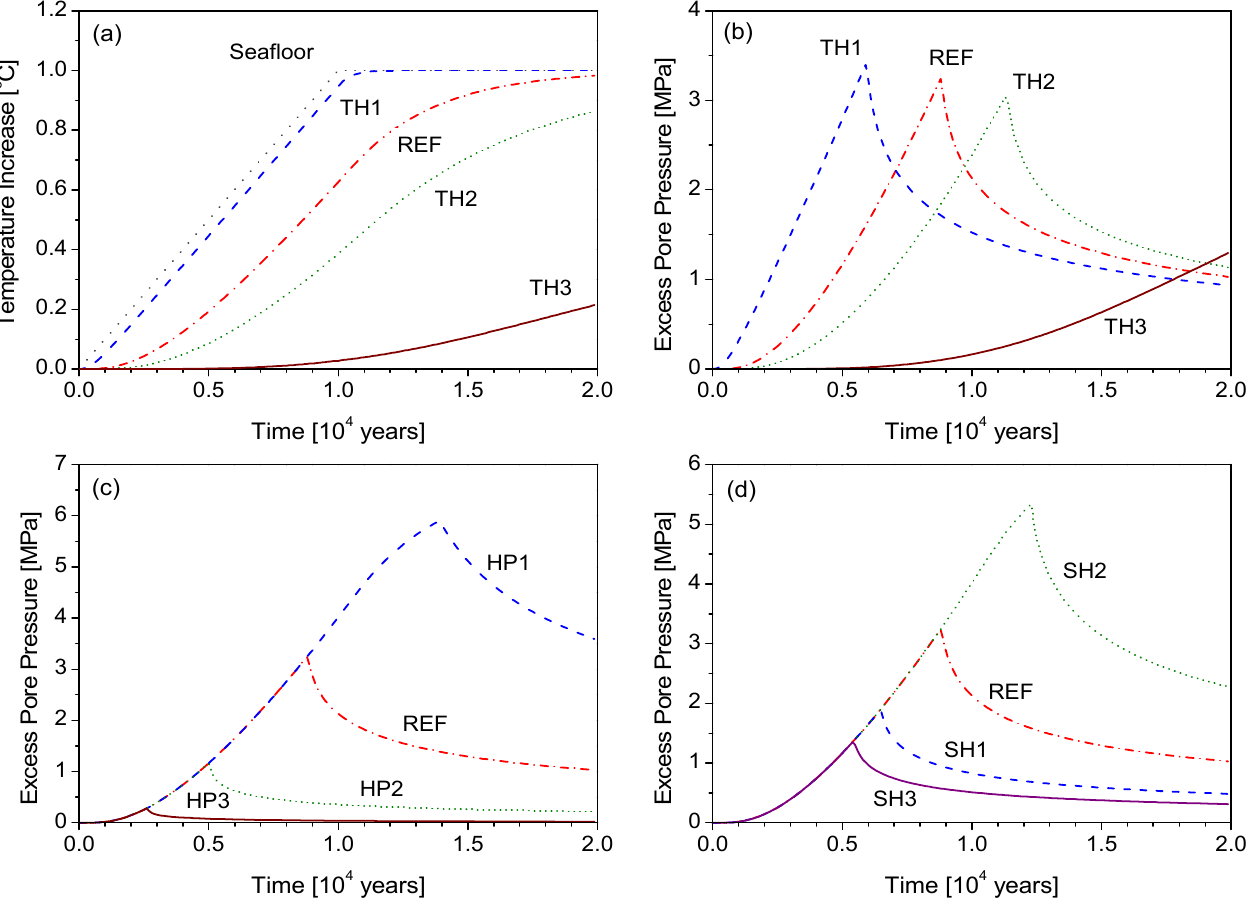
Figure 10. Results of the cases studied: ( a ) thermal responses at the BHOZ for the cases of TH1, TH3, and TH3; ( b ) excess pore pressure at the BHOZ for the cases of TH1, TH2, and TH3; ( c ) excess pore pressure at the BHOZ for the cases of HP1, HP2, and HP3; ( d ) excess pore pressure at the BHOZ for the cases of SH1, SH2, and